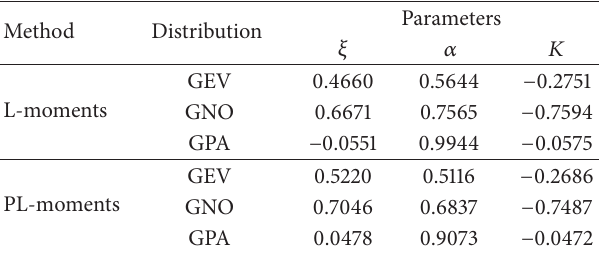
Table 6: Regional parameters for the three candidate distributions for L-moments and